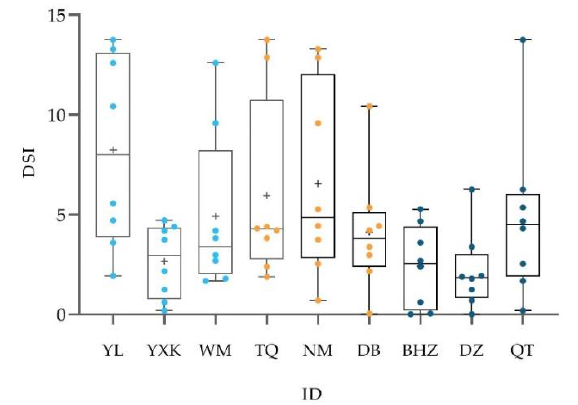
Figure 2. The distribution of DSI scores of males in the group. The plus sign indicates the average DSI score, and different colors indicate the rank class of the males (from left to right: high, middle, and low).